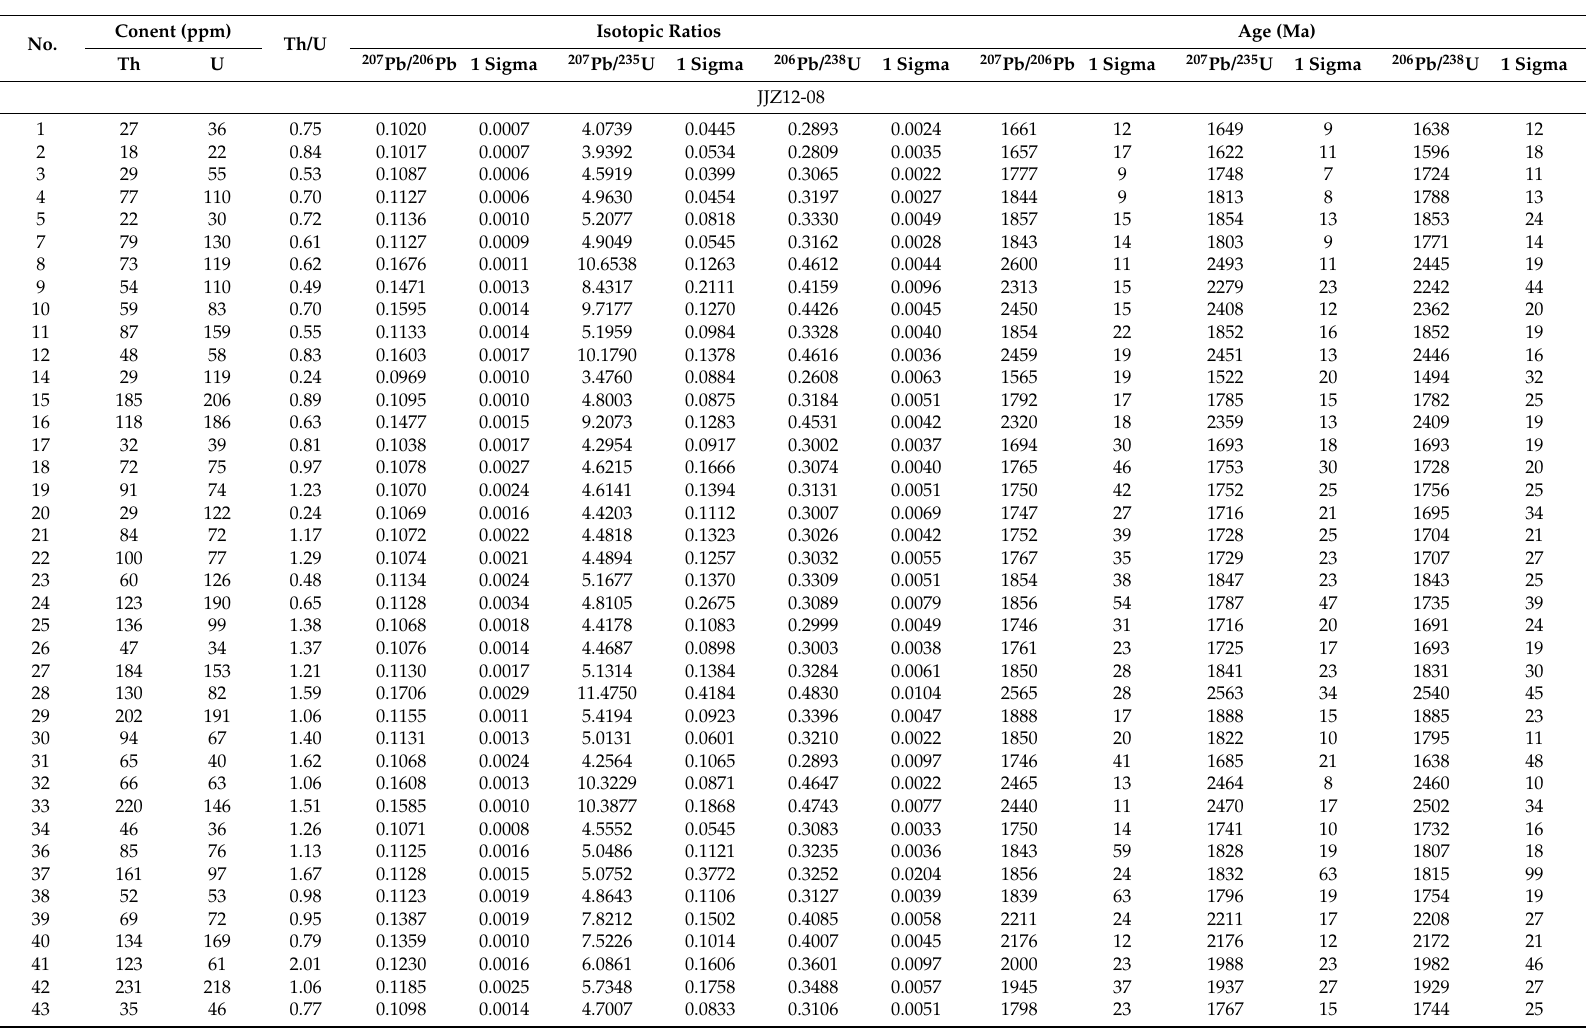
Table 1. LA-MC-ICP-MS U-Pb dating data for detrital zircons from the Chuanlinggou